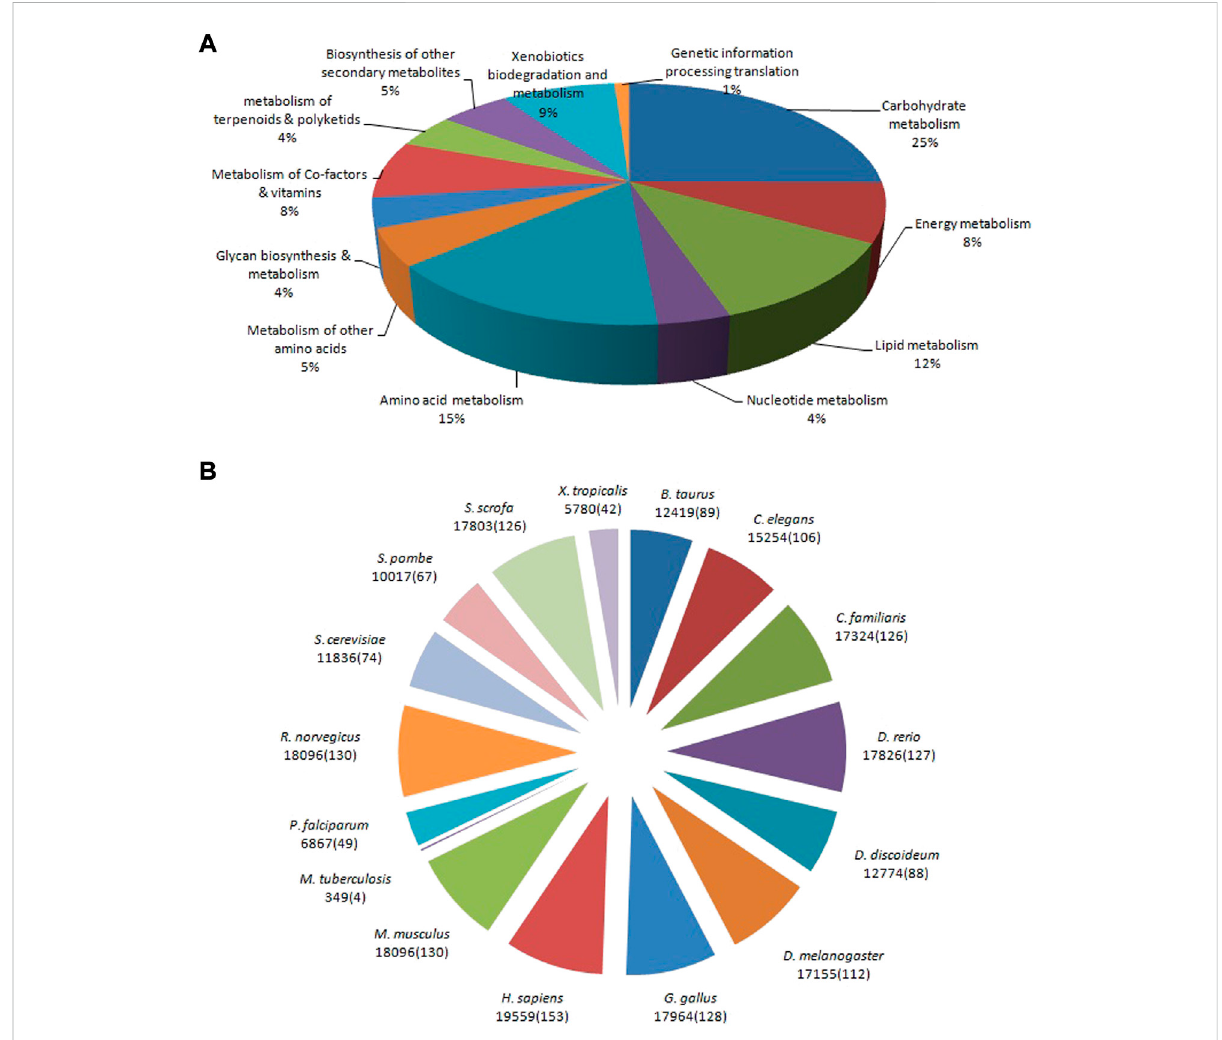
FIGURE 7 Pathway assignment based on the Kyoto Encyclopedia of Genes and Genomes: KEGG (A) and Reactome (B) databases.